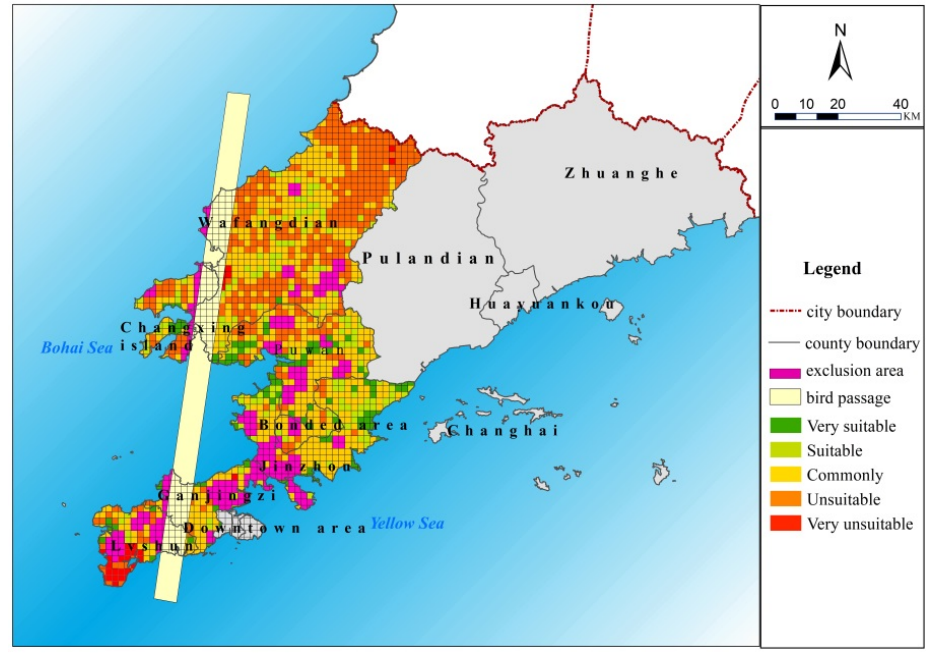
Figure 6. Evaluation results based on historical wind speed.